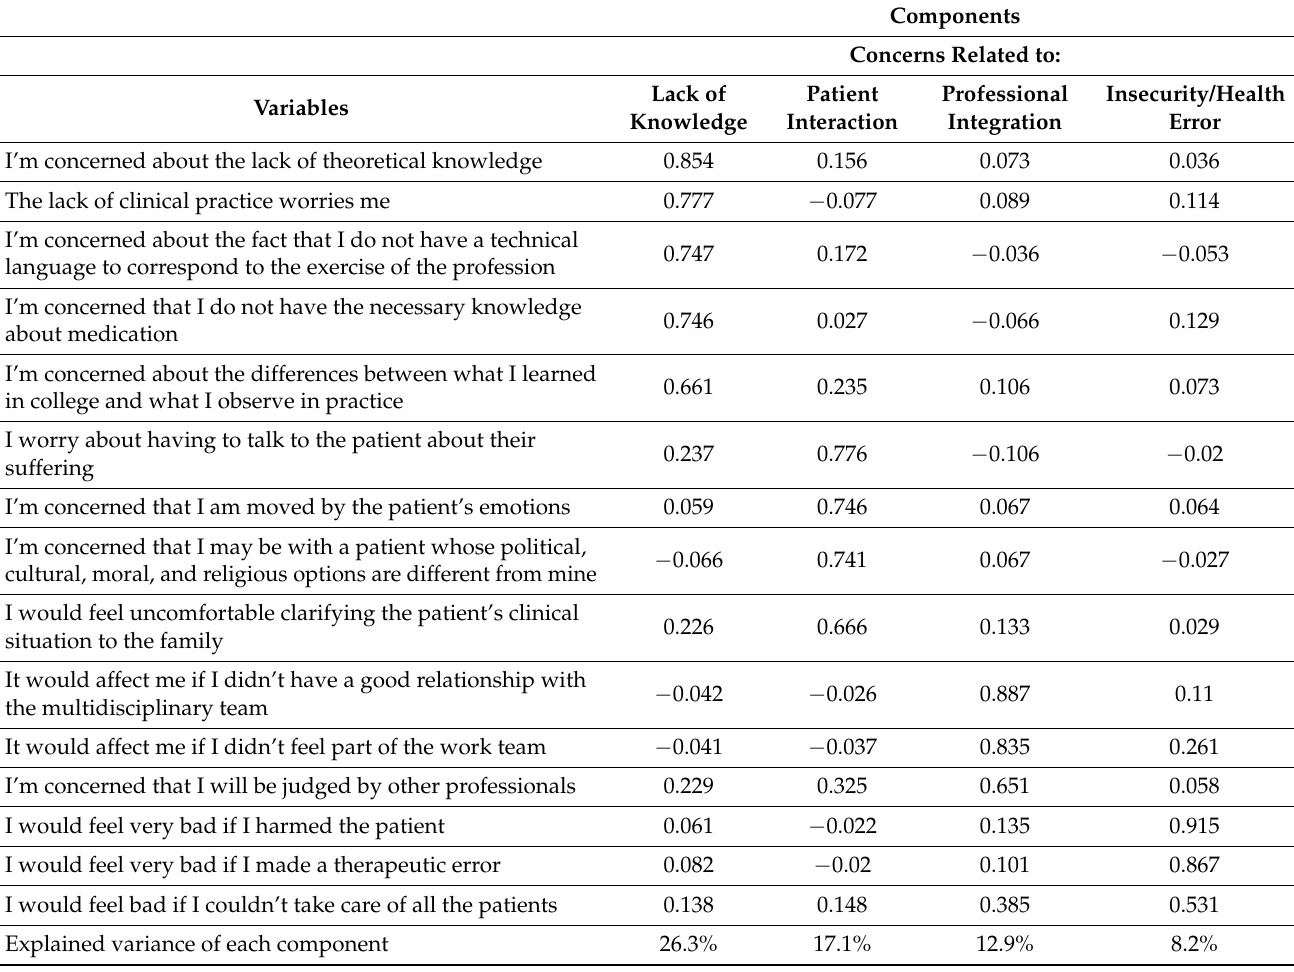
Table 3. Rotating Component Matrix of